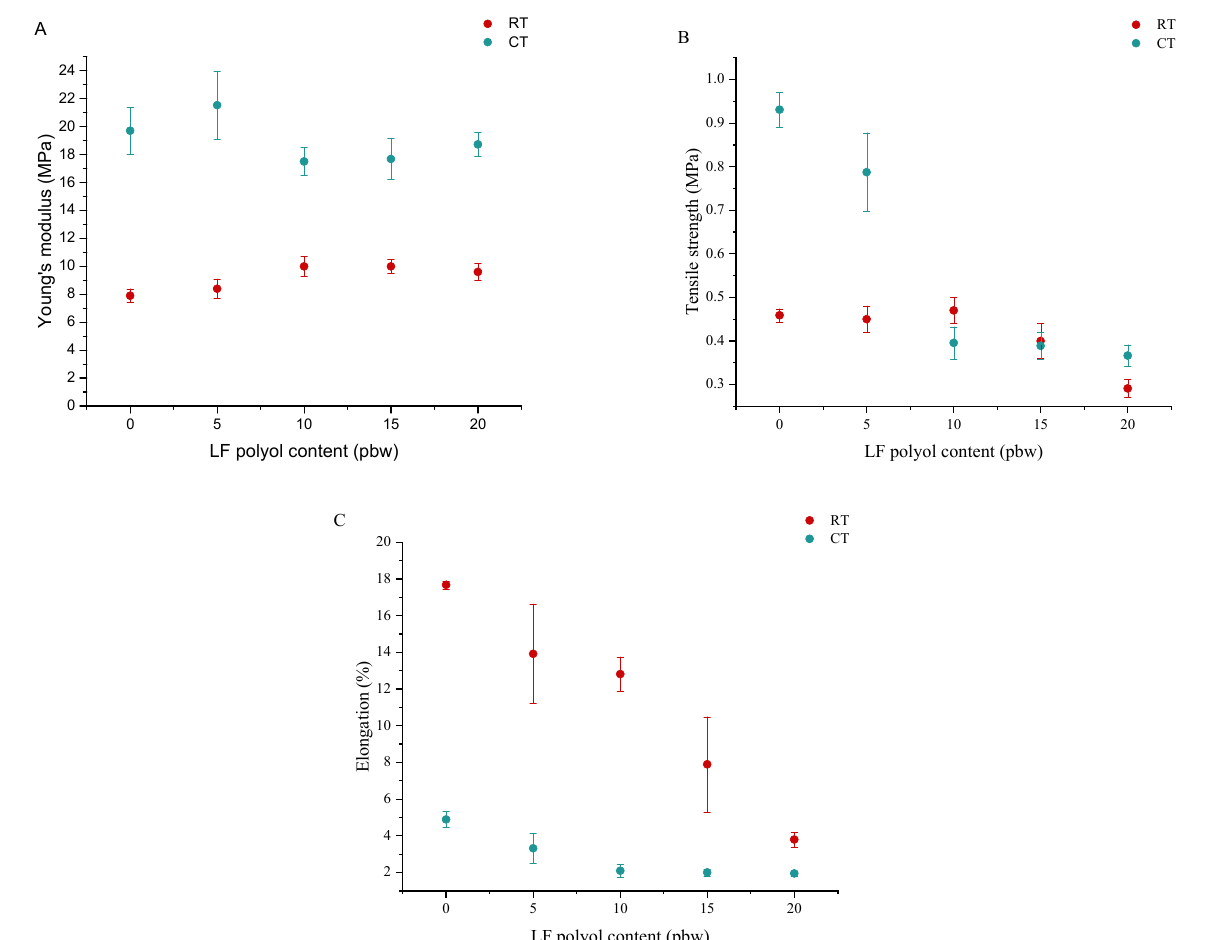
Figure 3. Tensile modulus (Young’s) ( A ), tensile strength ( B ) and elongation at break ( C ) of foams at RT and CT.